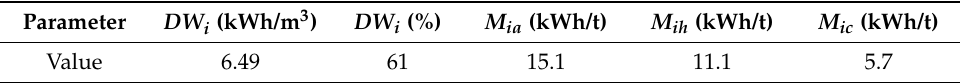
Table 2. Material parameters of the SMC tests.